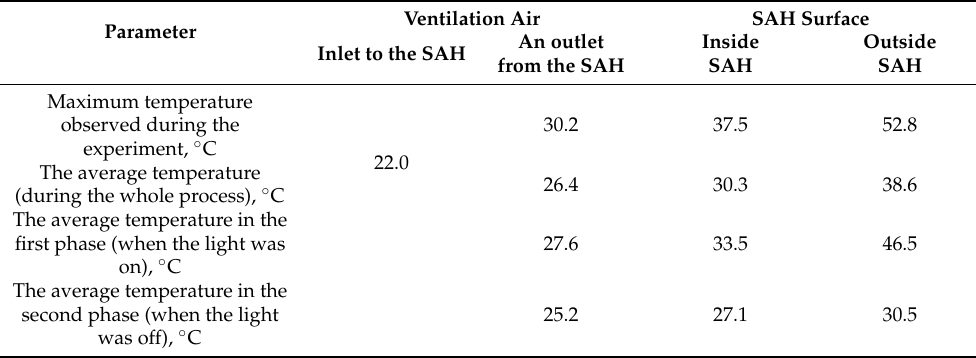
Figure 7. Variations in the ventilation air temperature (at the outlet and inlet to the SAH) and temperature of the SAH surface when it operated as the solar chimney (Series 1a). Table 5. Summarization of the temperature of the ventilation air and the SAH surface when it operated as a solar chimney (Series